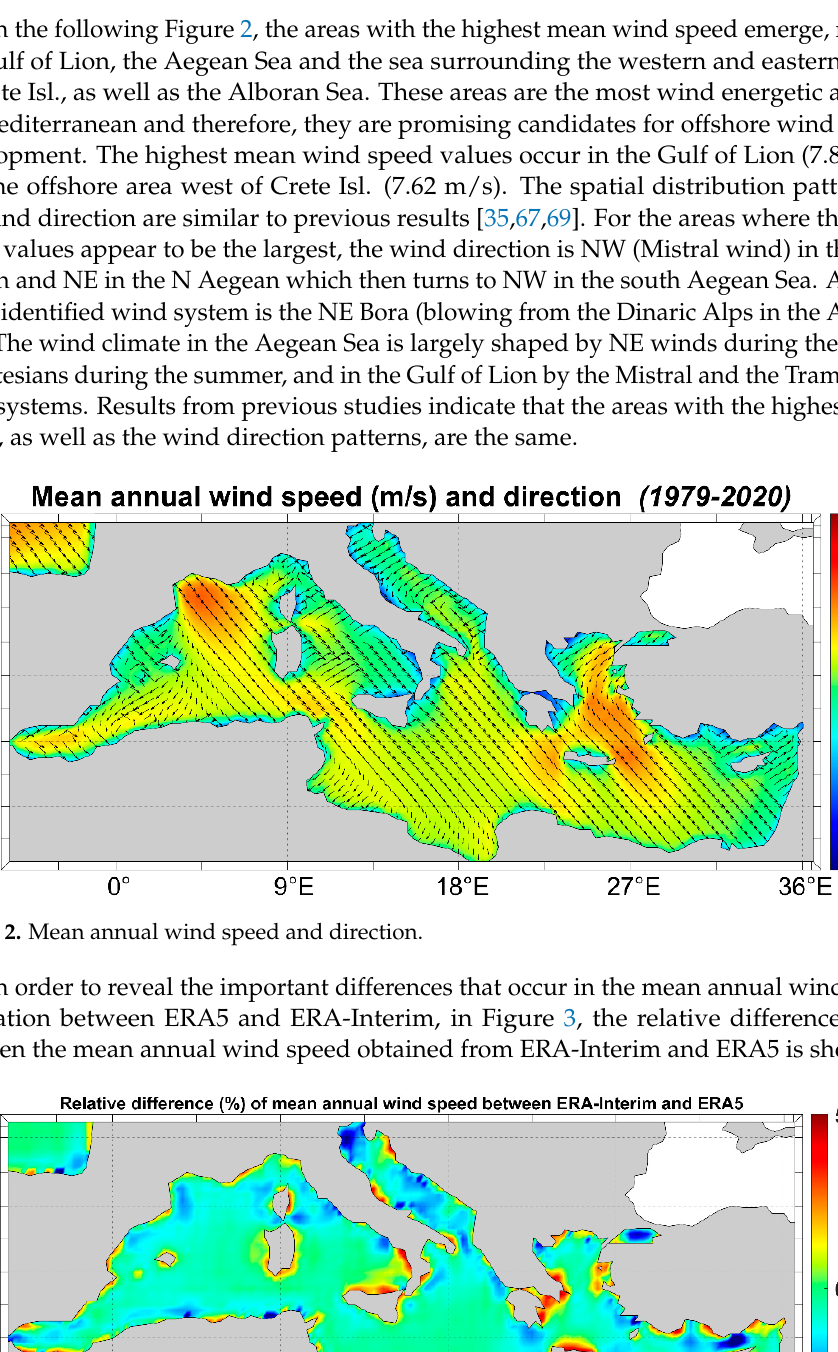
Figure 1. Mediterranean areas that are mentioned in the text.